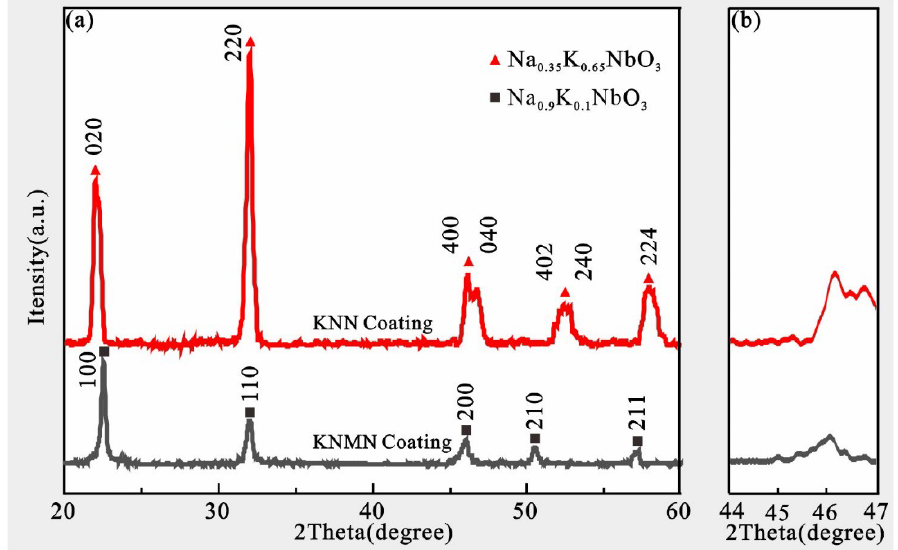
Figure 8. ( a ) XRD patterns of KNN, KNMN coatings. ( b ) 44°–47° XRD extended patterns.